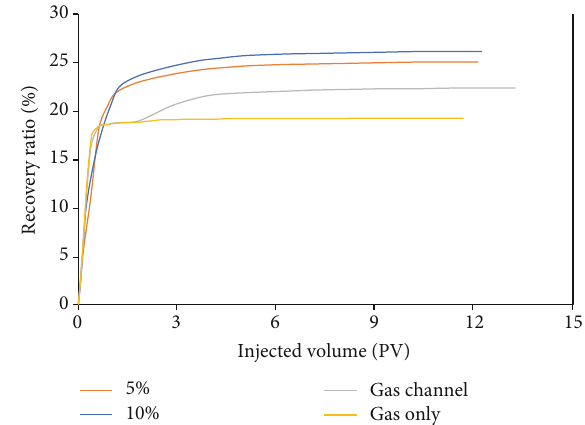
Figure 5: Curve of the relationship between injection volume of alternating gas-water fl ooding and sweep e ffi ciency in di ff erent times.